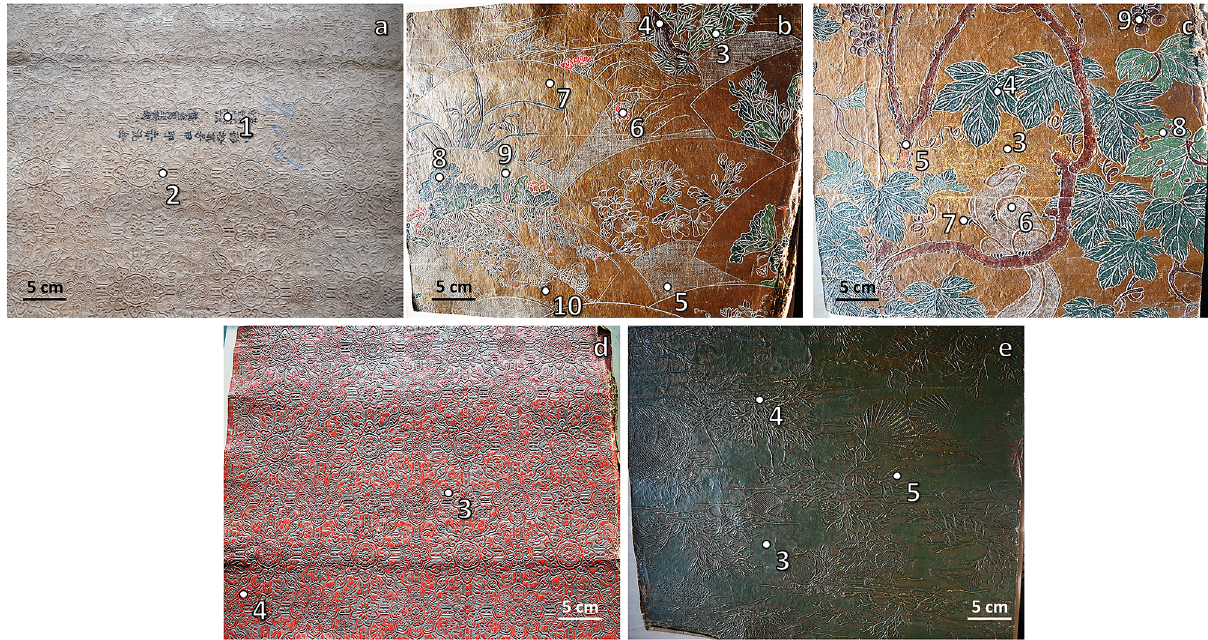
Figure 1. Kinkarakawa-gami wallpapers. In ( a ) is depicted the verso of one of the wallpapers and the points 1 (written portion) and 2 (non-written portion) that were chosen—for all the artefacts—for the analyses, while the wallpapers’ recto and the investigated sampling points (numbers) are represented in ( b ) INV_11 (3–10), ( c ) INV_13 (3–9), ( d ) INV_15 (3–4), and ( e ) INV_20